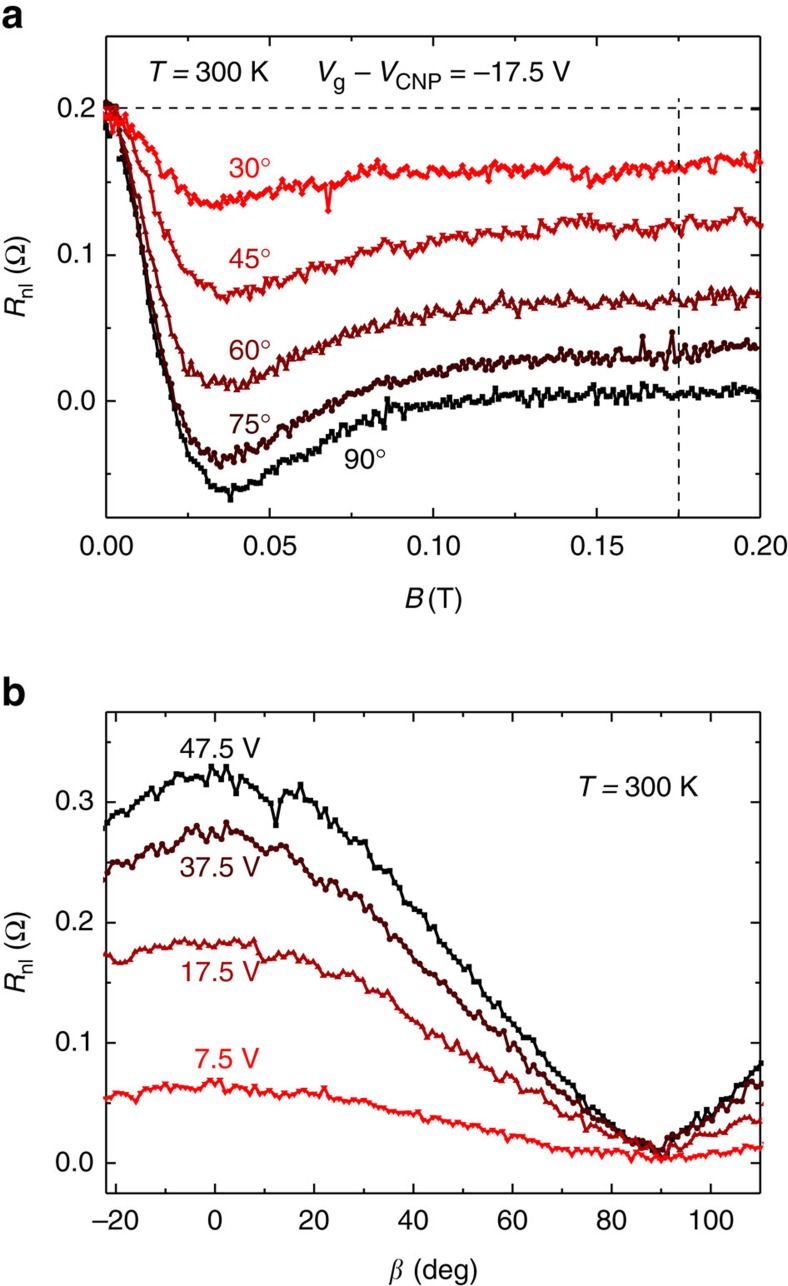
Spin precession measurements under oblique magnetic fields.(a) Representative subset of experimental spin precession curves for β=30°, 45°, 60°, 75°, 90°. The precession data are acquired at T=300 K and Vg−VCNP=−17.5 V, using an injector current of I=10 μA, after preparing a parallel configuration of the electrodes. The horizontal dashed line is the non-local resistance at B=0, Rnl(B=0), which coincides with Rnl at β=0° in the parallel configuration. (b) Angular dependence of Rnl at fixed magnetic field B=175 mT>Bd for representative Vg. This magnetic field is shown with a vertical dashed line in a; Vg−VCNP=47.5, 37.5, 17.5, 7.5 V.